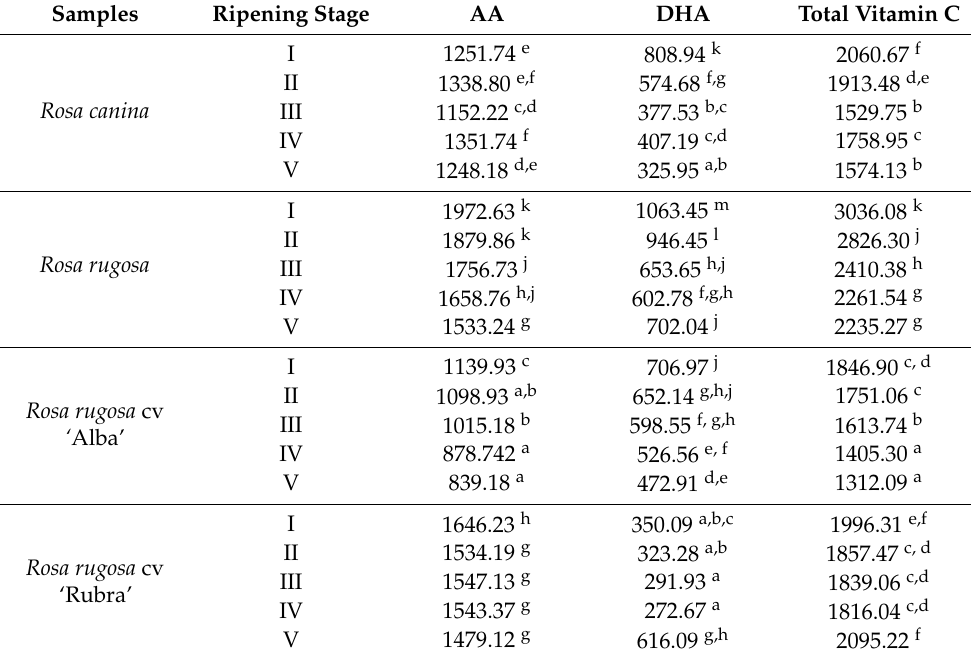
Table 6. Effects of ripening stage on the amounts of vitamin C in the rosehip fruits, mg 100 g − 1